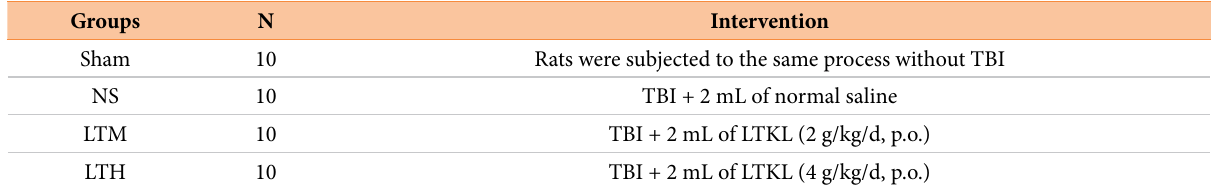
Table 1 - The grouping and intervention of